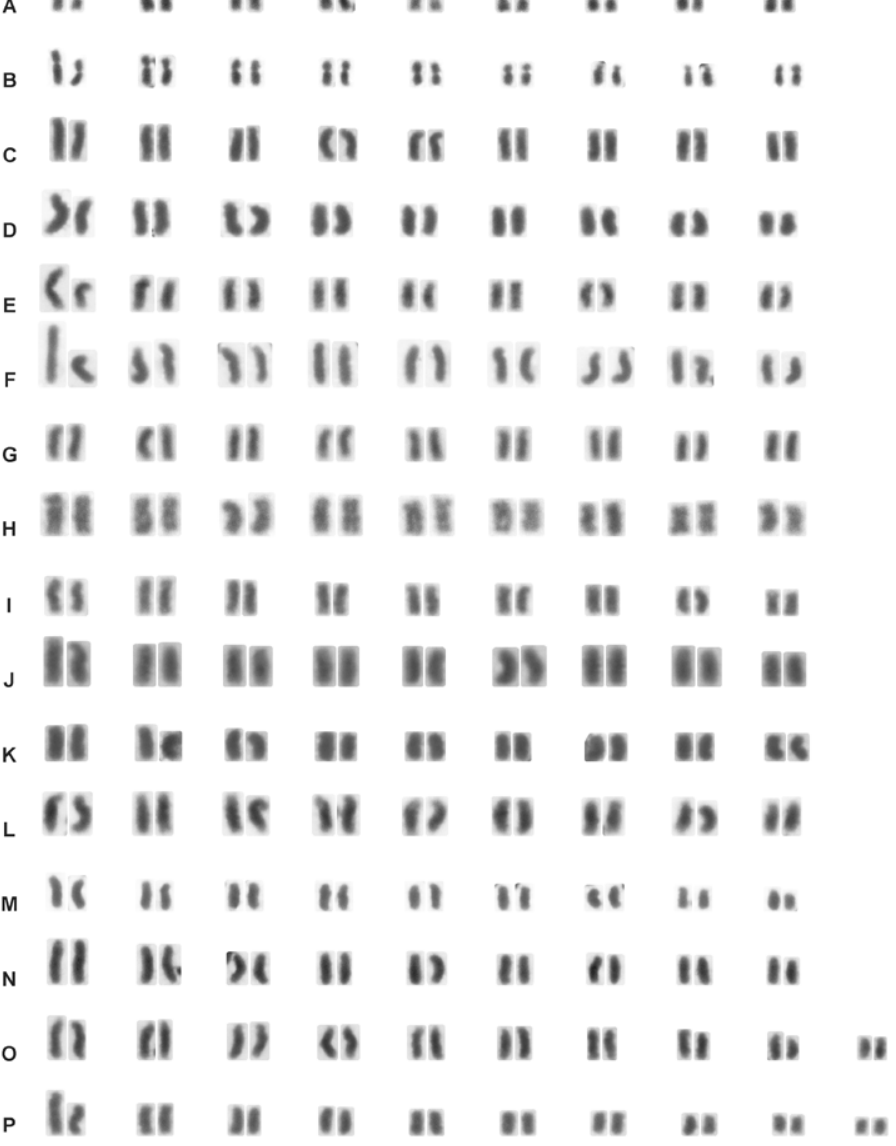
Fig 1 . Melipona karyograms based on Giemsa staining. Species with 2n = 18: Melipona bicolor (A), Melipona quadrifasciata (B), Melipona flavolineata (C), Melipona fuscopilosa (D), Melipona nebulosa (E), Melipona scutellaris (F), Melipona grandis (G), Melipona mondury (H), Melipona fasciculata (I), Melipona aff. flavolineata (Capixaba-AC) (J), M. aff. flavolineata (Brasiléia-AC) (K), M. aff. flavolineata (Xapuri-AC) (L), M. aff. flavolineata (Xapuri-AC) (M), Melipona crinita (N), and with 2n = 22 Melipona seminigra pernigra (O) and Melipona seminigra abunensis (P). The chromosomes were arranged in descending order of size . Bar = 10